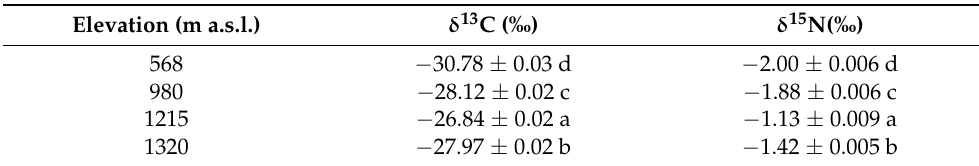
Table 3. Isotopic composition of carbon ( 13 C) and nitrogen ( 15 N) in the leaves of green alder (Alnus viridis ) collected in September from plants growing in the Bieszczady Mts. at various el- evations